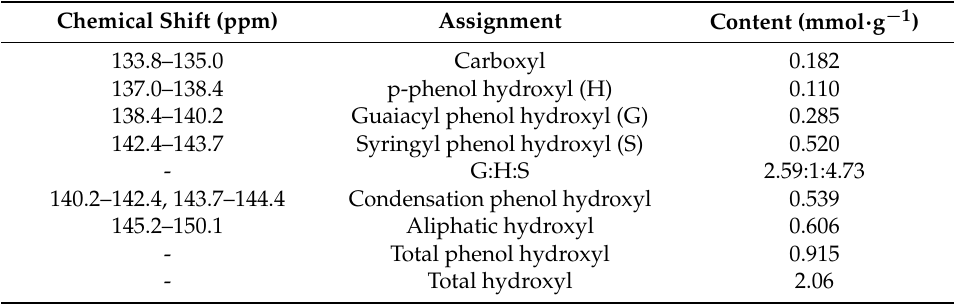
Table 5. 31 P NMR analysis of DES-Lignin.